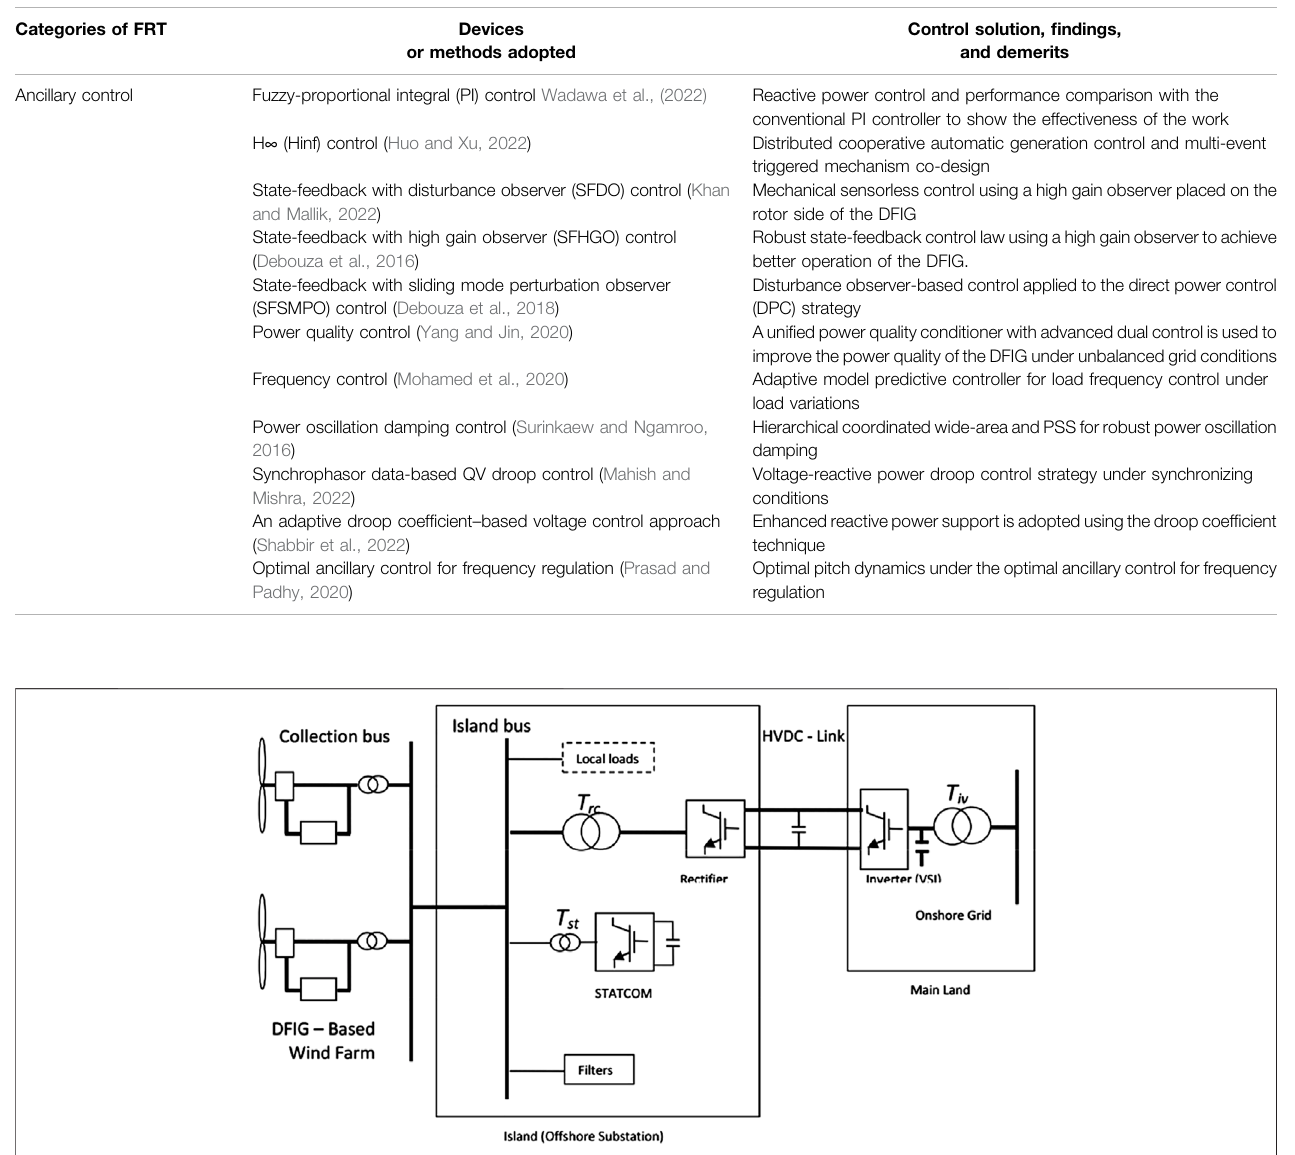
FIGURE 1 | WECS connected to the HVDC-based grid-connected